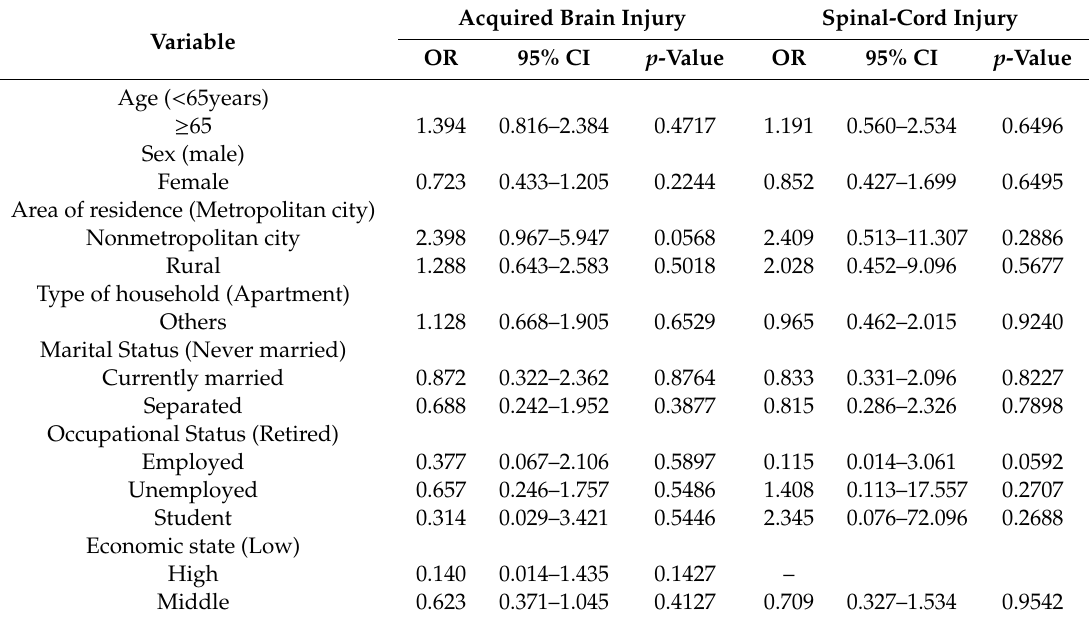
Table 6. Factors associated with severe disability measured using International Classification of Functioning, Disability, and Health (ICF) in multivariate logistic